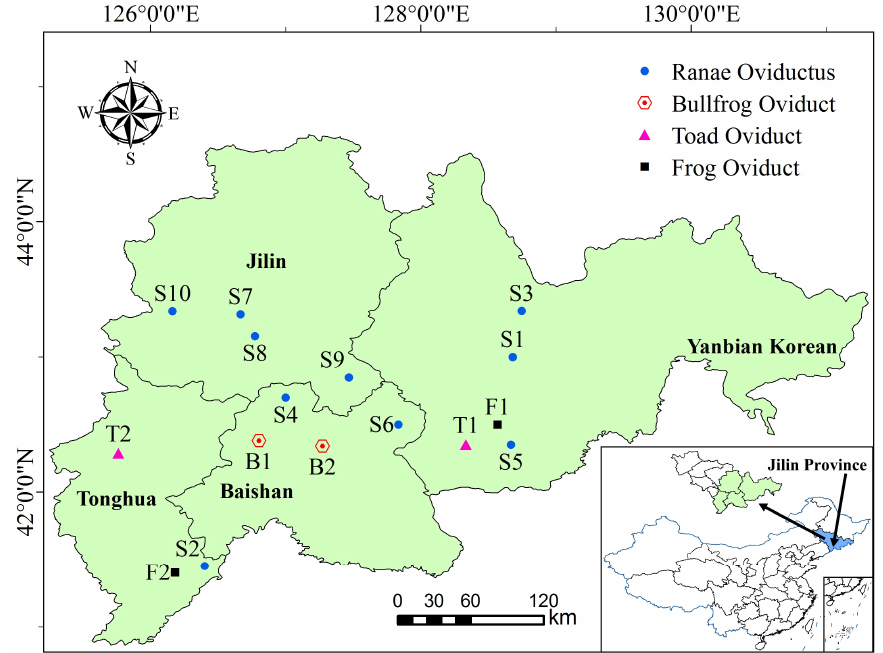
Figure 1. Distribution map of origins for Ranae Oviductus and its counterfeits in the Changbai mountain area. Table 1. Origin and collecting date of the Ranae Oviductus samples and their counterfeits. No.